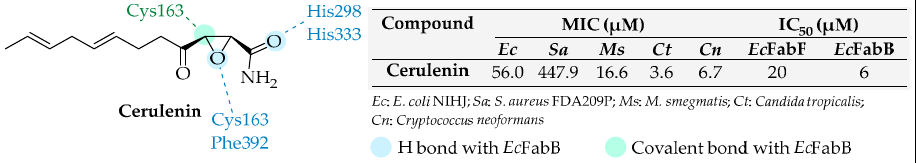
Figure 16. Structure, representation of main interactions with Ec FabB and in vitro activities of ceru- lenin